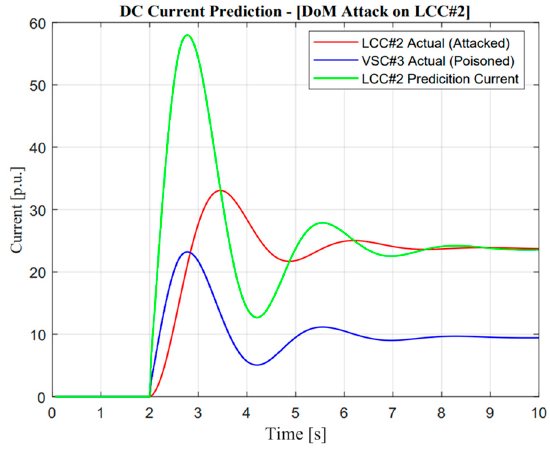
Figure 15. DC current prediction in delay of measurement attack operation.